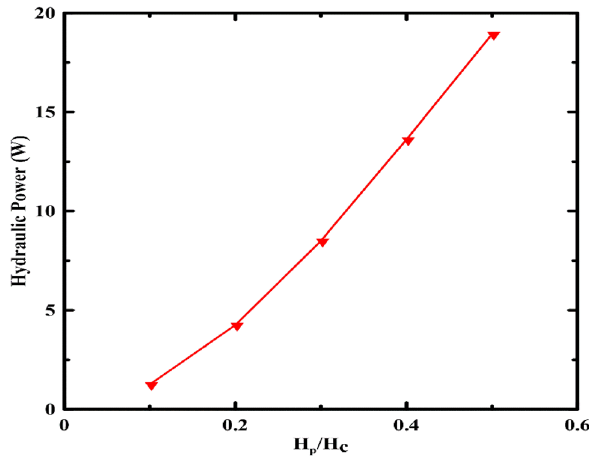
Figure 4. Effect of piston height variation on the hydraulic power.